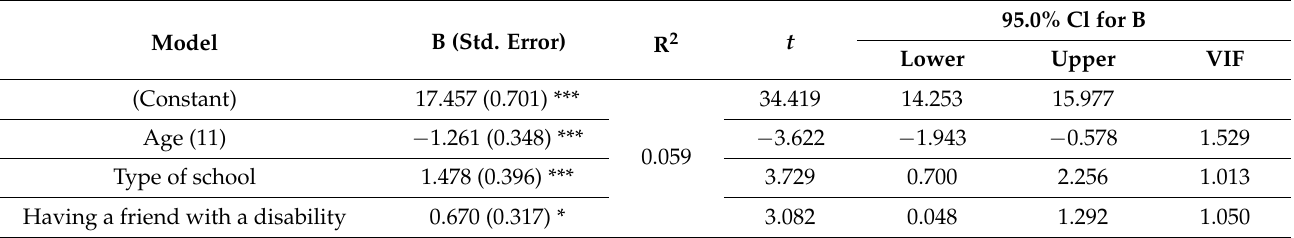
Table 2. Stepwise linear regression model for individual predictors of the attitudes toward peers with disabilities in physical education among Saudi students aged